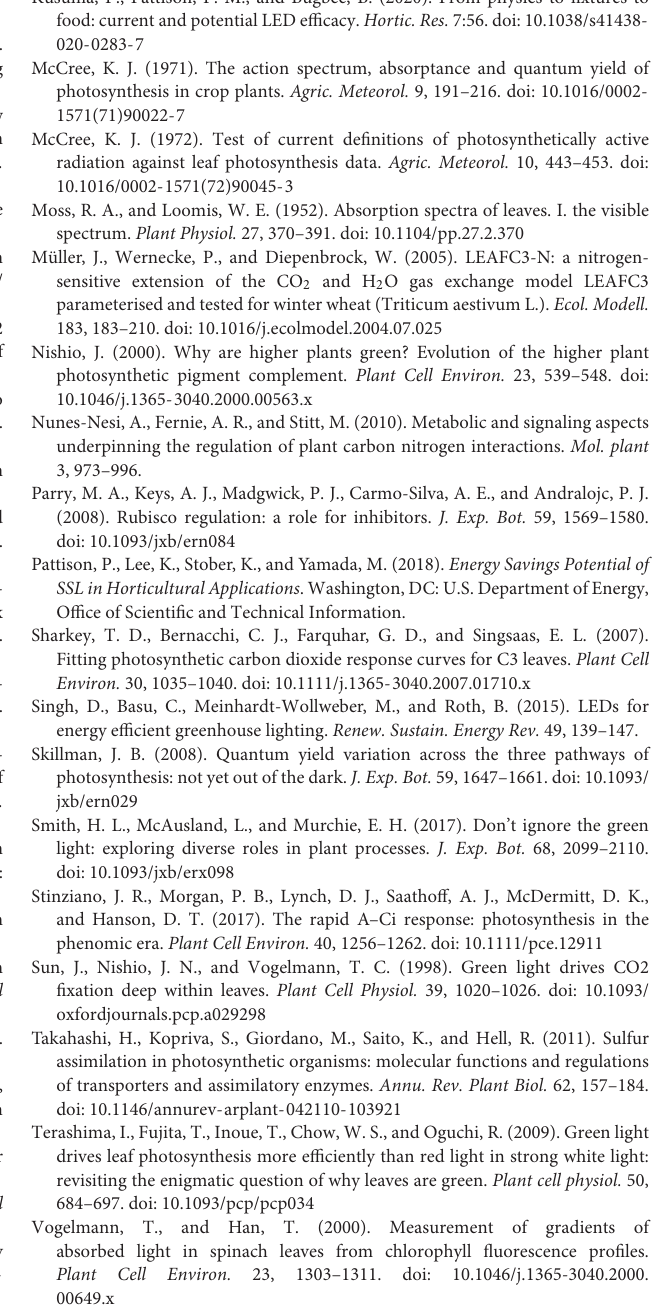
remaining photons available to support Calvin cycle processes (B) . Note that the pattern of QY inc after correcting of alternative electron sink (B) is similar to quantum yield of PSII measured by chlorophyll fluorescence by Weaver and van Iersel (2019). Supplementary Table 1 | Dark respiration rate (R d ), maximum quantum yield of CO using Eq. 1. The light response curves are shown in Figure 3 . *See light composition of nine lights presented here in Table 1